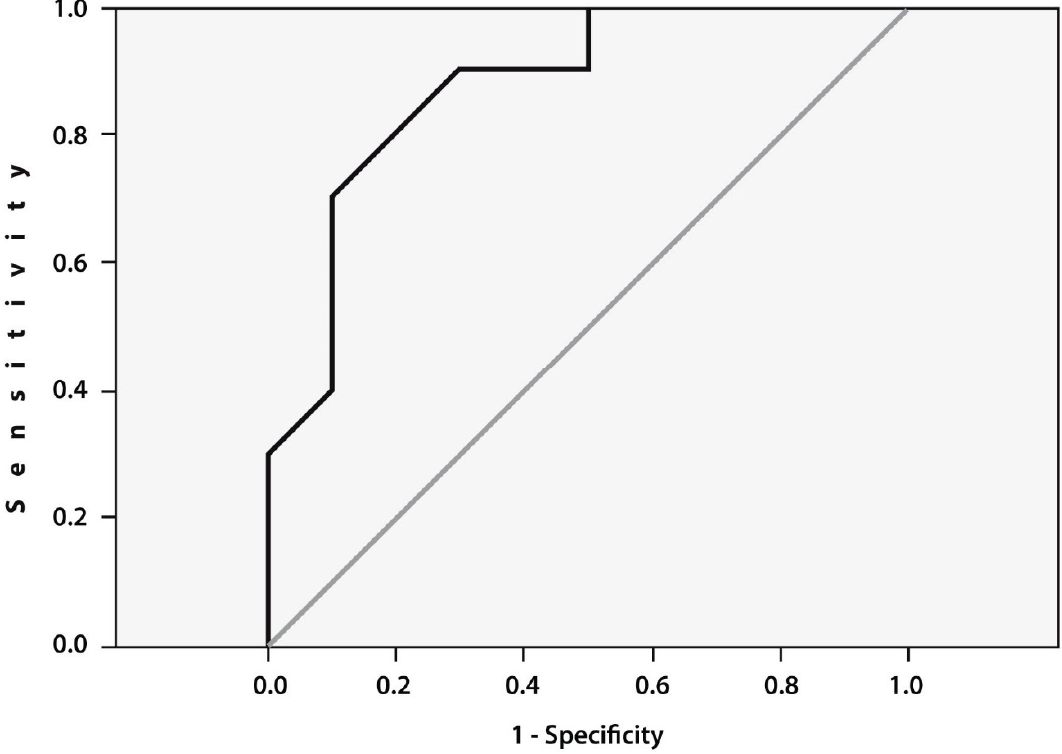
Figure 2. Area under the curve (AUCs) between the baseline TNF α gene expression in the peripheral blood mononuclear cells of patients with RA cultured with tofacitinib for 48 h prior to therapy. Receiver-operating characteristic (ROC) curve for the expression of TNF α (AUC = 0.875, 95% CI (0.718–1.000), p = 0.005).